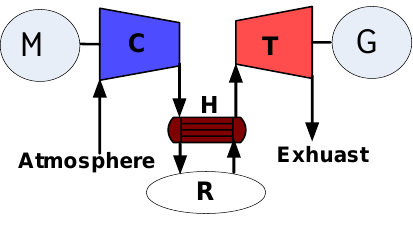
Figure 6. Schematic diagram of AA-CAES system (C—Compressor, T—Turbine, G—Generator, M—Motor, R—Reservoir, H—Thermal storage).